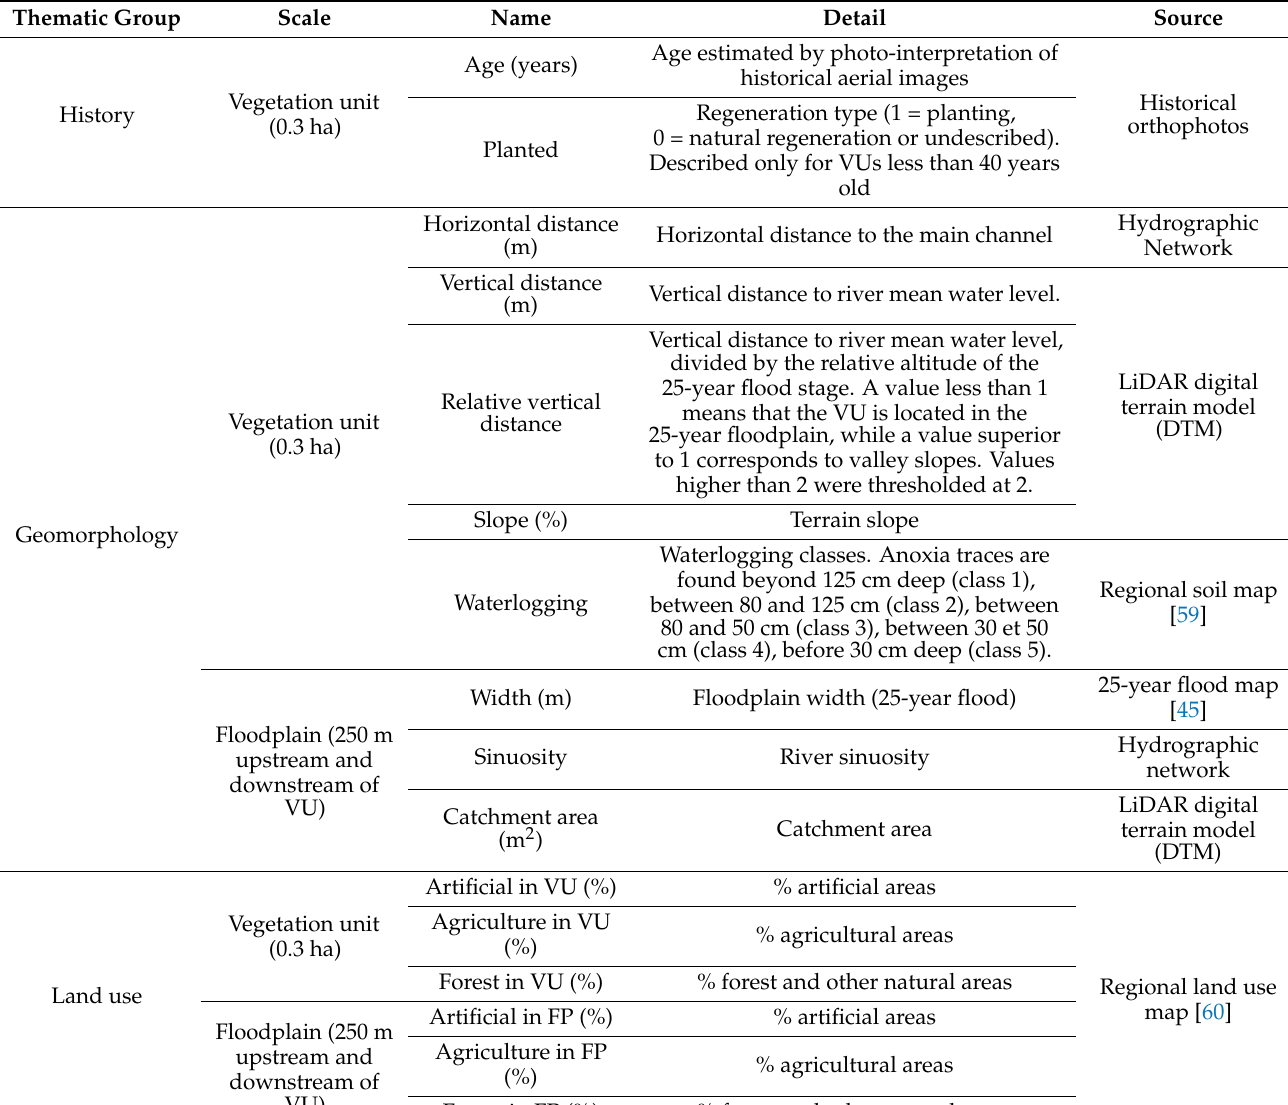
Table 2. Explanatory variables used to analyze VU biomass